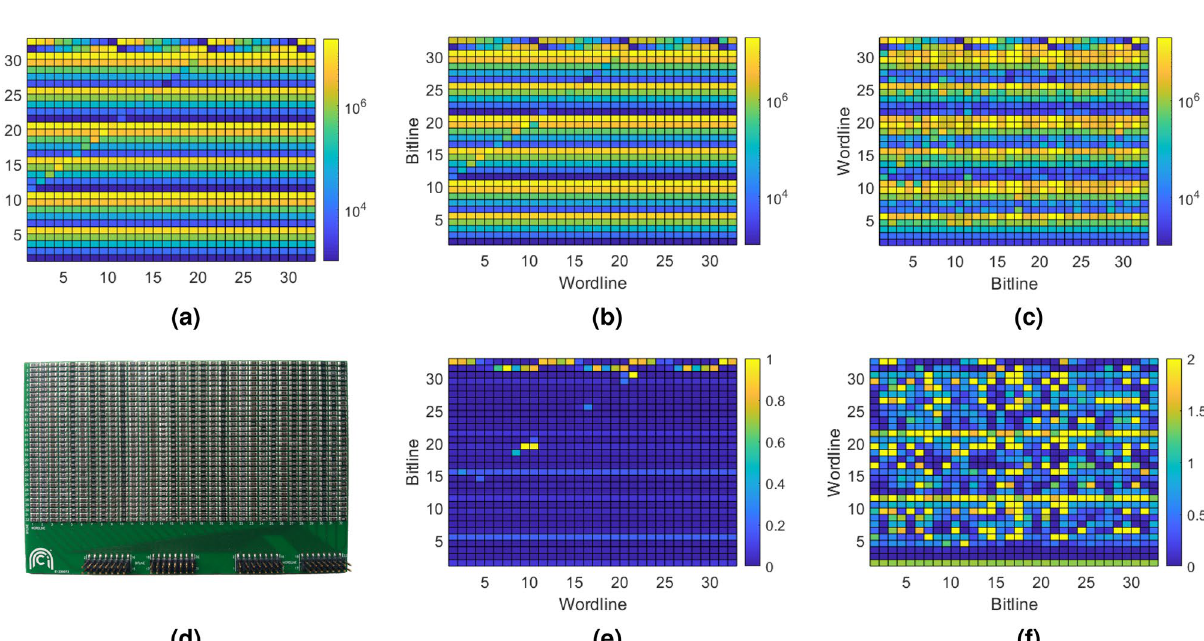
Figure 9. Array read operations for a 32 × 32 resistor array. ( a ) shows the array as designed, with resistors ranging from 1 k (cid:31) to 15M (cid:31) . The colourbar is scaled from 1 k (cid:31) to 20M (cid:31) Figure. ( b ) shows the array as read in columns. ( e ) shows the proportional error of b. ( c ) shows the array as read in rows. ( f ) shows the proportional error of ( c ).